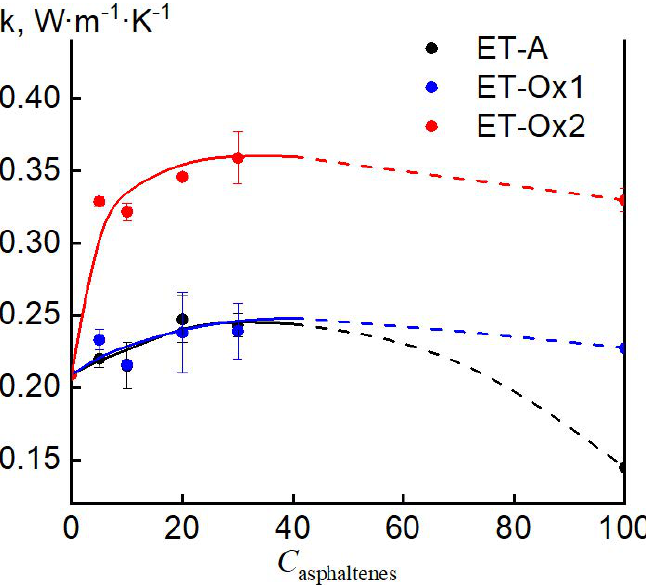
Figure 9. Concentration dependence of the thermal conductivity of composites based on paraffin containing asphaltenes of various nature, T = 25°C.